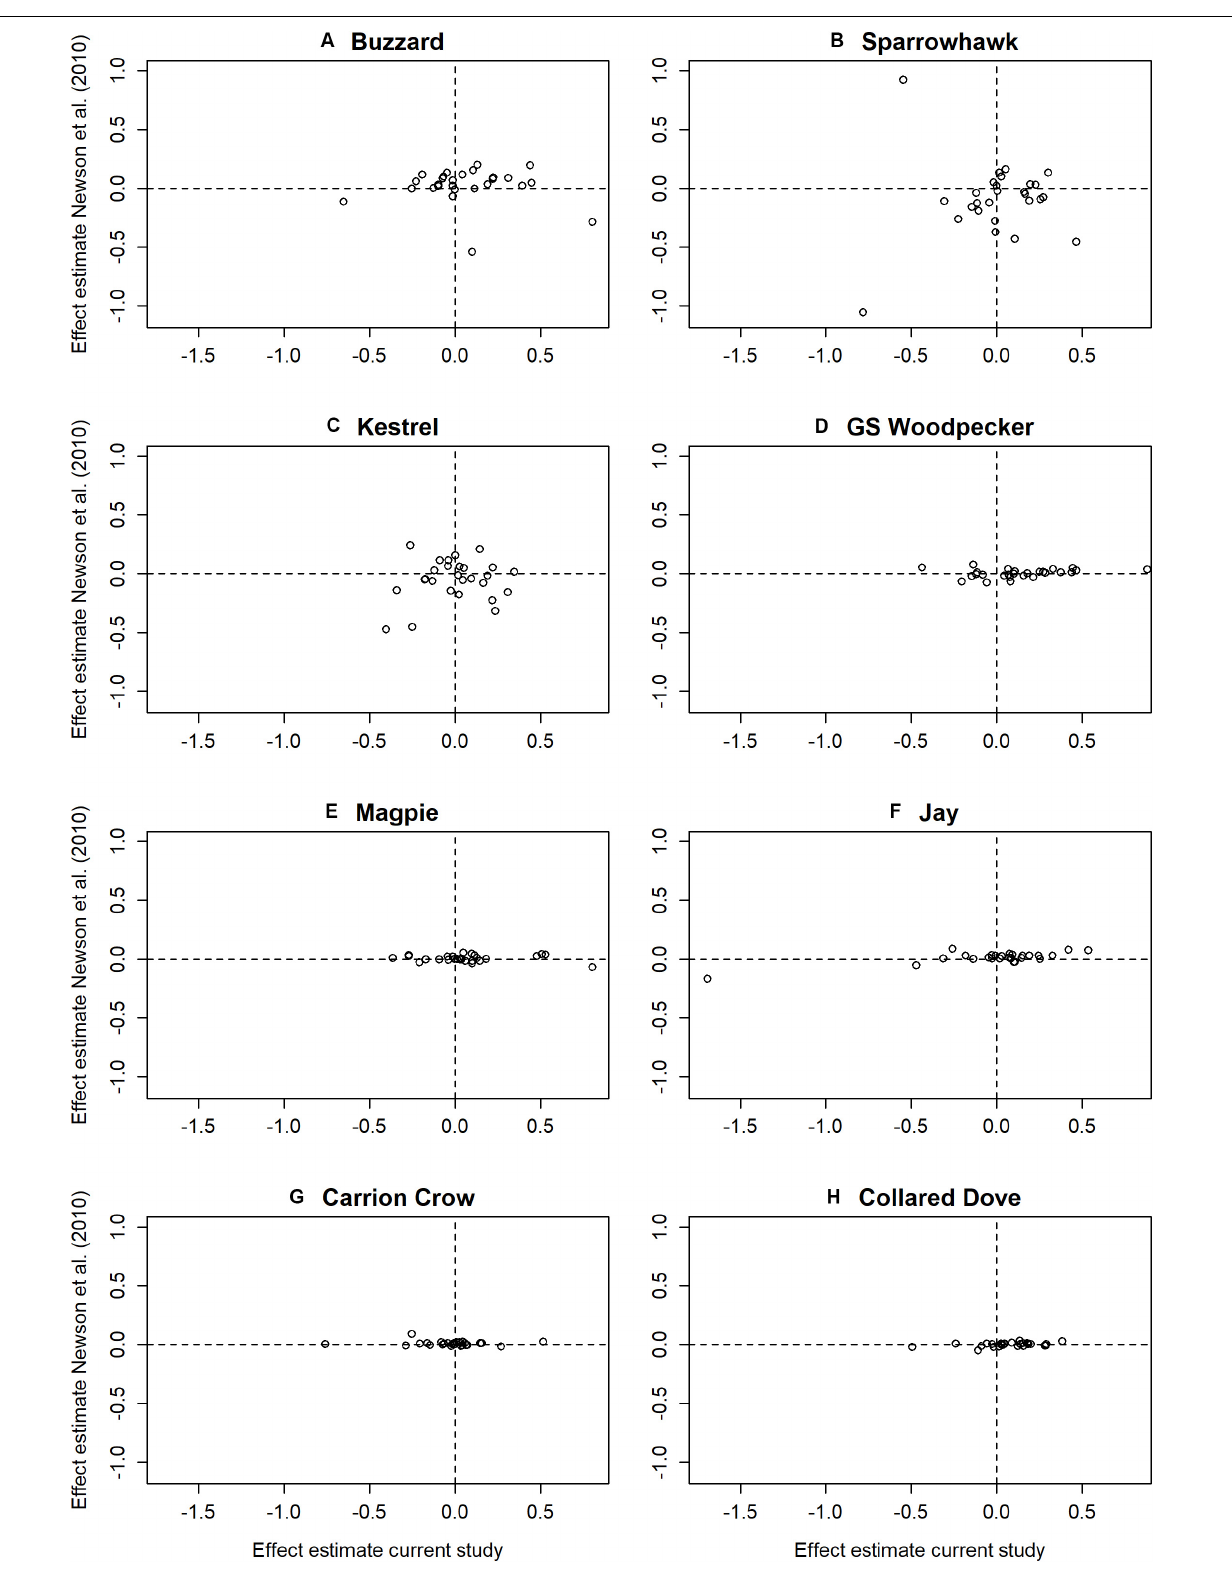
Frontiers in Ecology and Evolution |